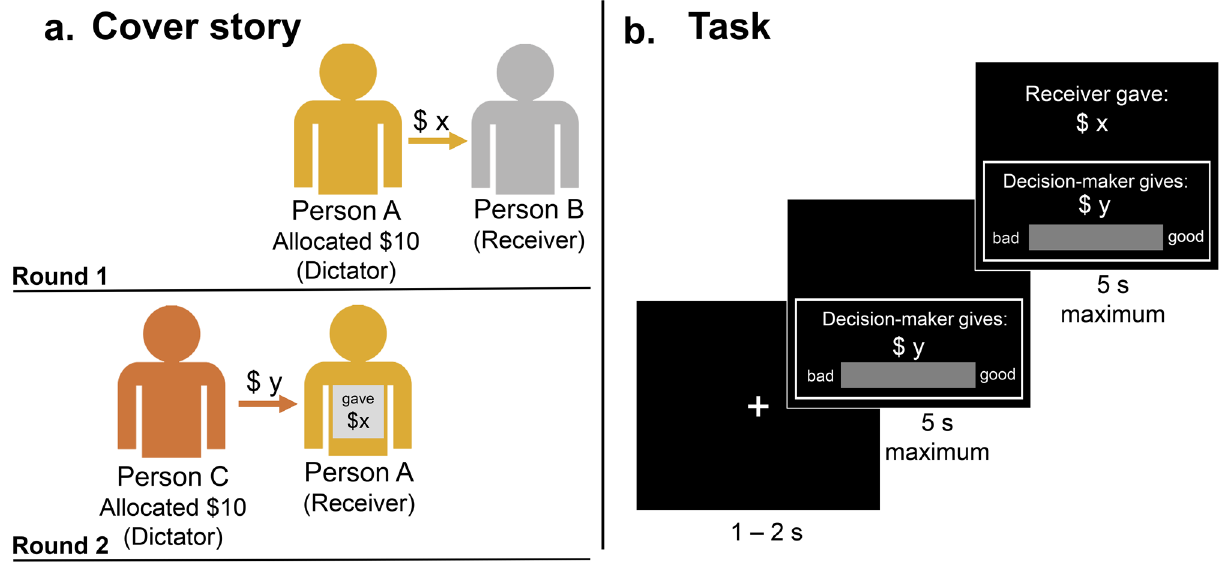
Figure 1. Experimental paradigm. ( a ) Depiction of the cover story presented to participants before completing the experiment. In Round 1, Person A played the role of the Decision-maker, was given $10, and decided how much of that amount they would give to their partner, Person B. In Round 2, Person A became the new Receiver. A new person, Person C, became the Decision-maker, was given $10, and decided how much they would